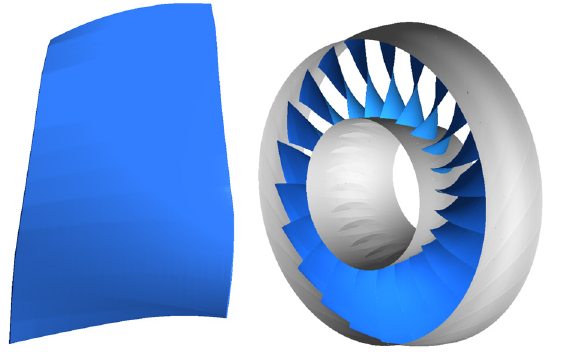
Figure 7. R67 Figure 7. R67 model.